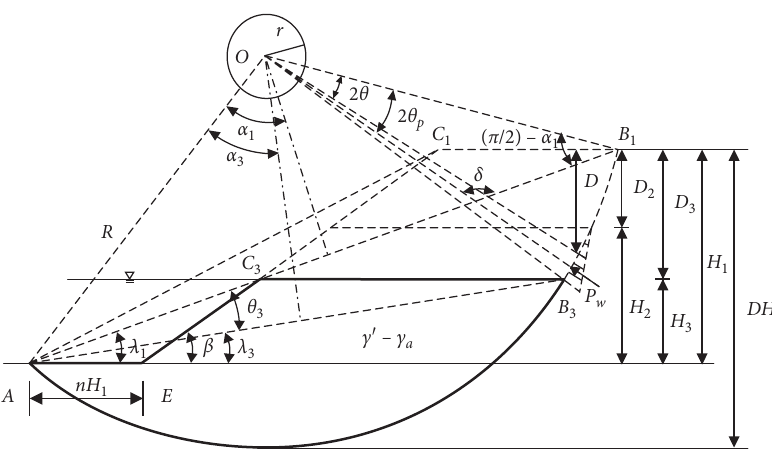
Figure 3: A slope model showing water drawdown and the geometric denomination.